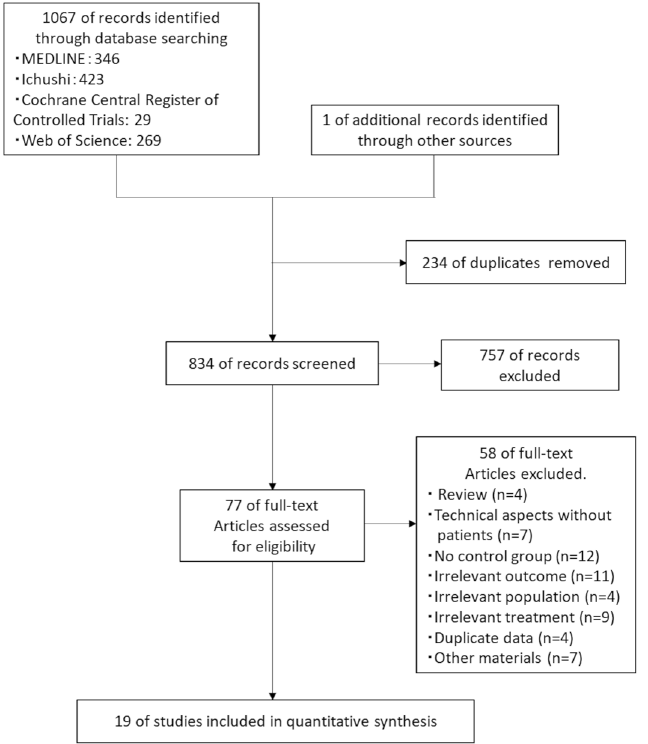
Figure 1. PRISMA flowchart for clinical outcomes 41 . PRISMA preferred reporting items for systematic reviews and